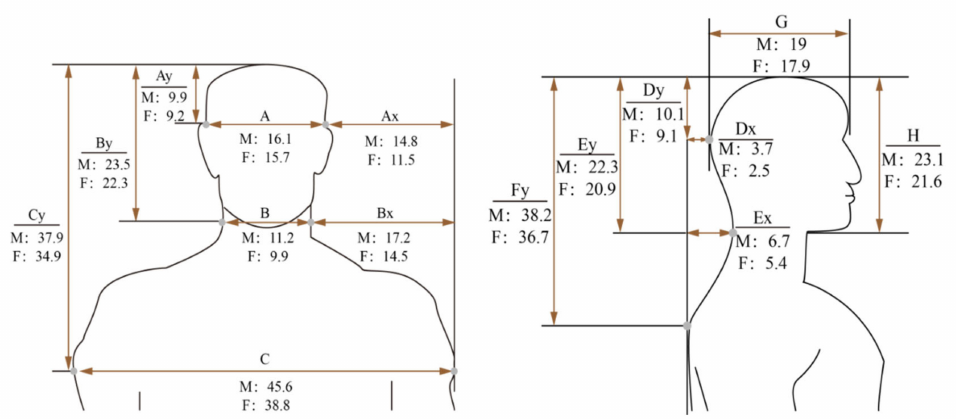
Figure 3. Anthropometric parameters measured by Cai and Chen [21]. Key parameters: width from ear to shoulder, Ax; the length from the hindbrain to wall, Dx; the length from neck to wall, Ex.